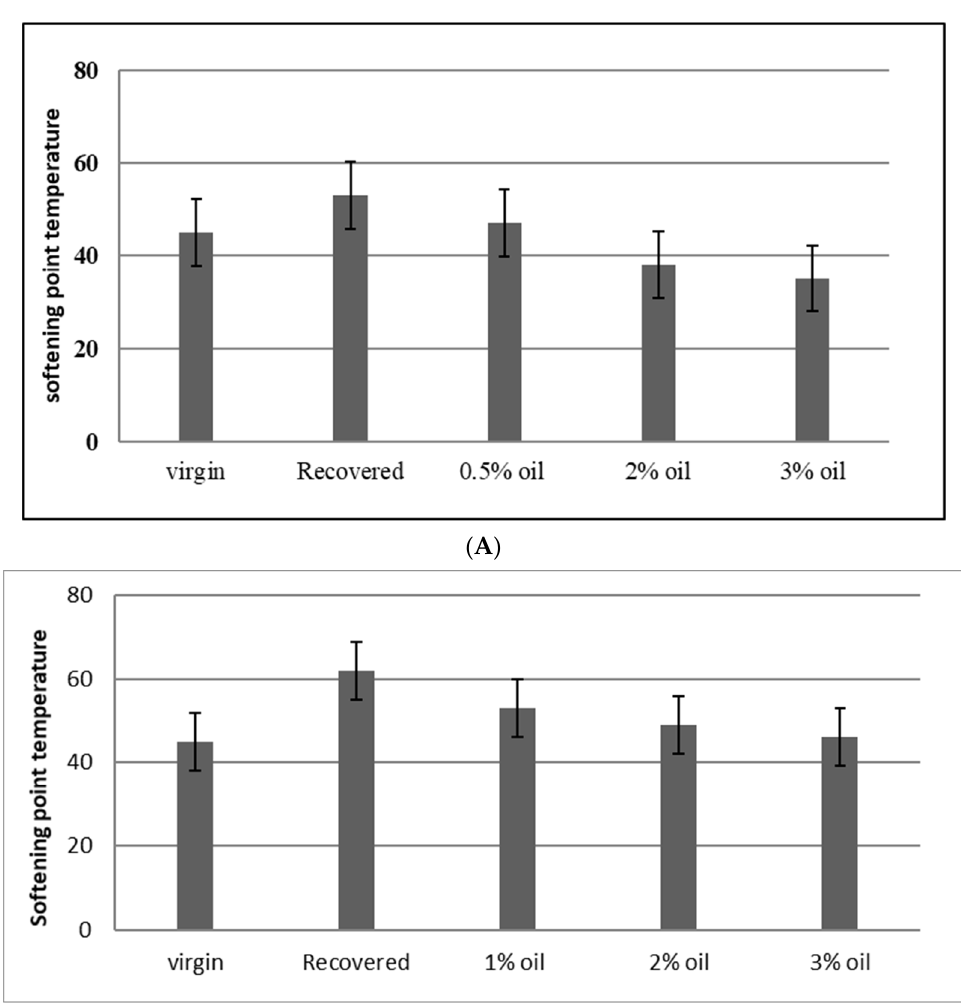
Figure 6. Softening point temperatures for virgin, recovered, and rejuvenated bitumen with WEO